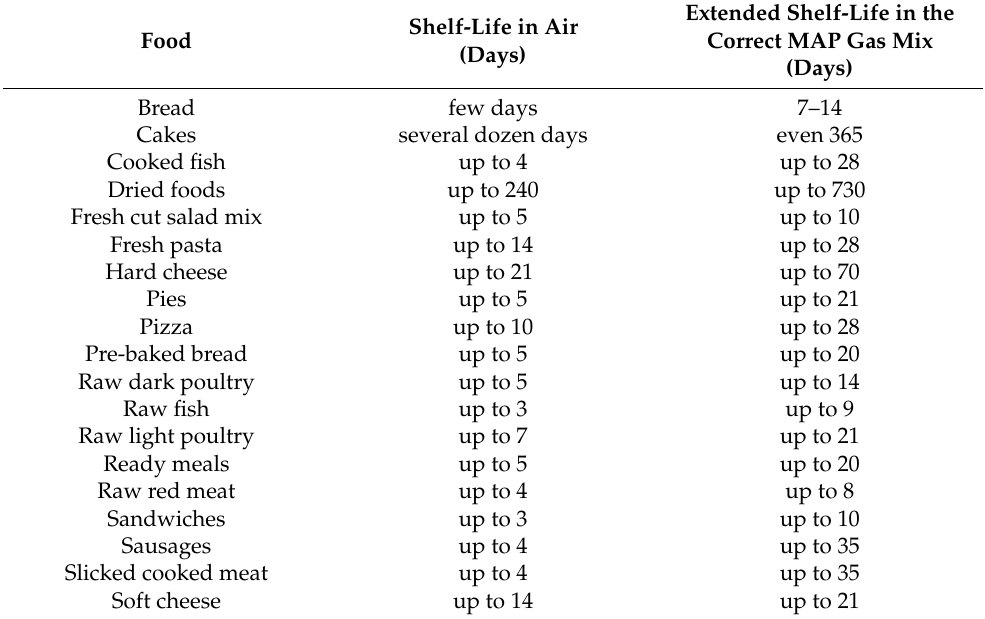
Table 1. The shelf-life list of different products with or without MAP